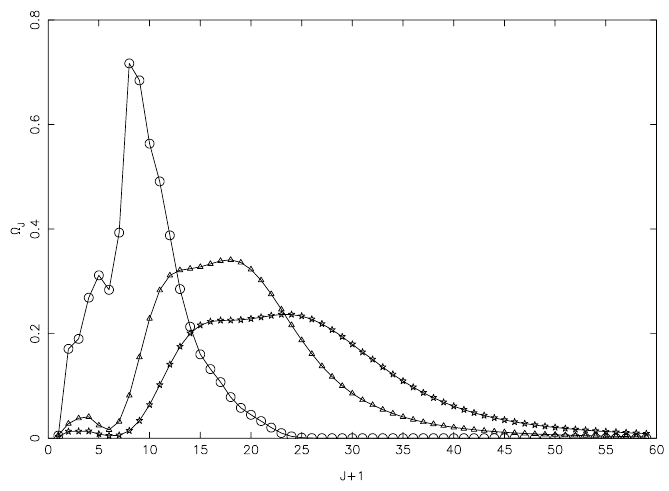
Figure 10. Partial collision strengths for the 4s 2 S 1/2 –4f 2 F o energies of: 4 Ryd (circles), 6 Ryd (triangles) and 8 Ryd (stars).